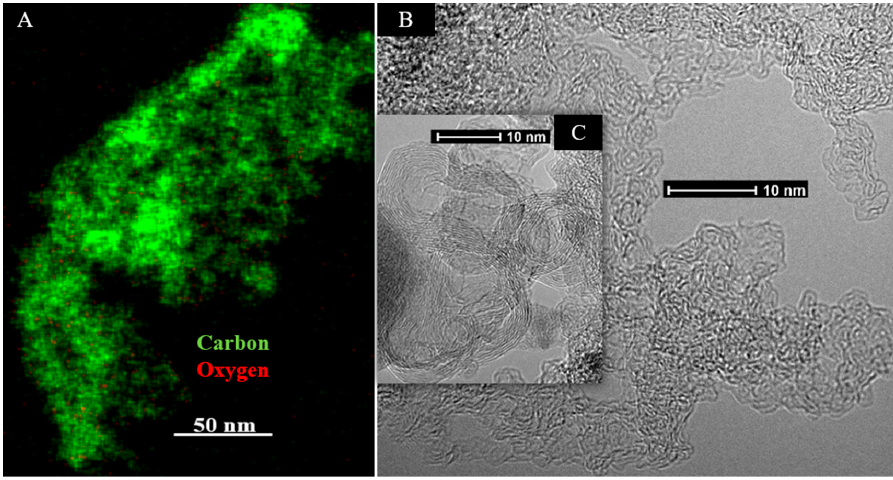
Figure A5. TEM images of anthracene coke—200 mJ/cm 2 .